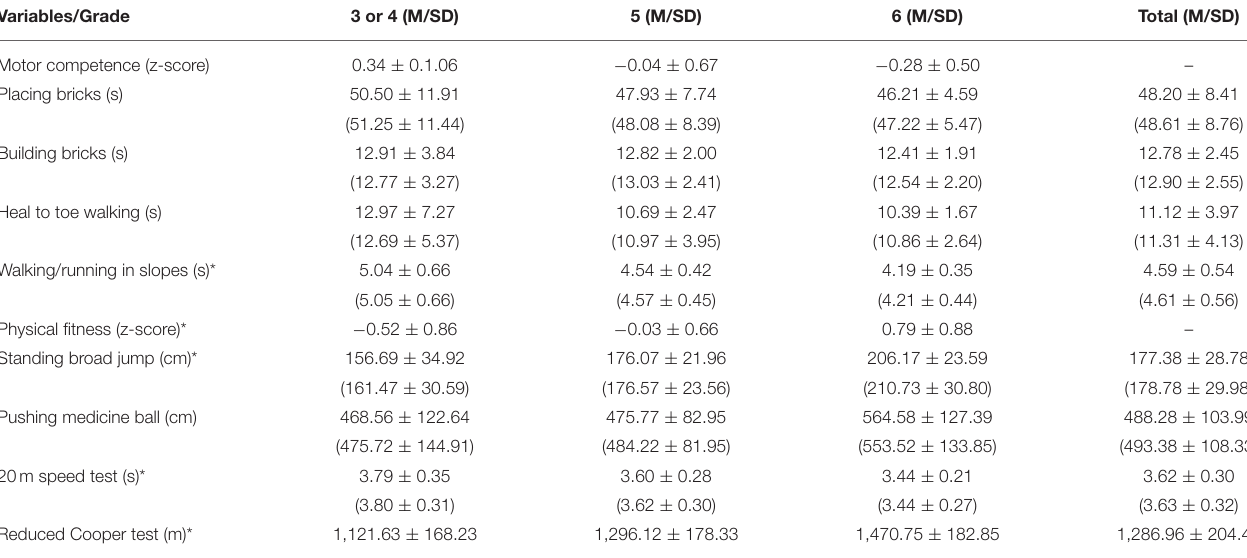
TABLE 2 | Measures of physical fitness and motor competence by grade ( N = 76).